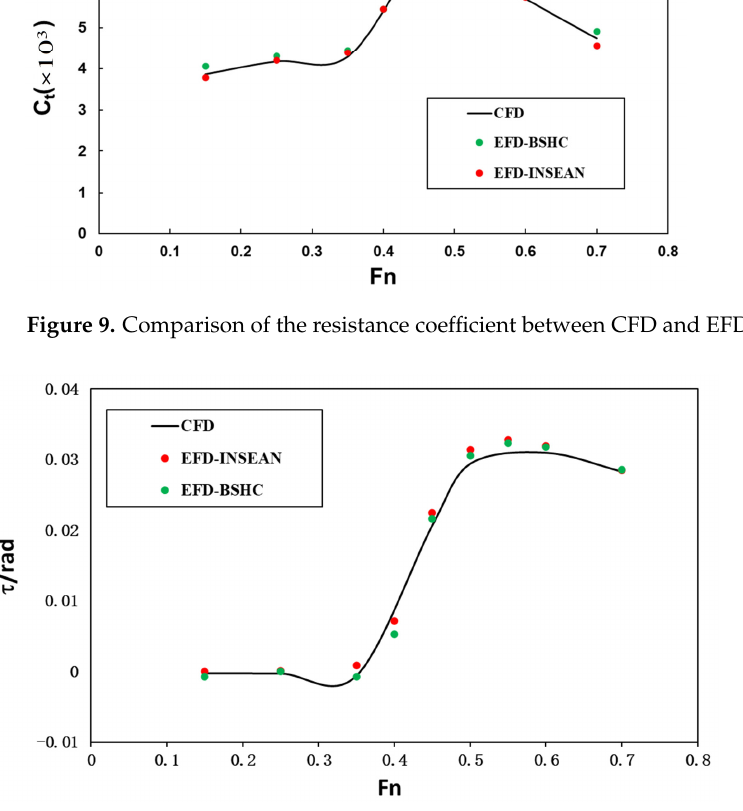
Figure 10. Comparison of the trim between CFD and EFD results.